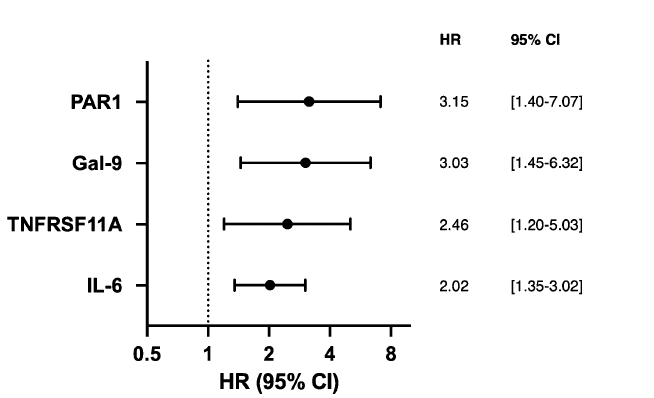
Figure 1. Biomarkers with a significant positive or negative predictive value for cardiovascular events and mortality, identified by multivariate cox regression analysis.